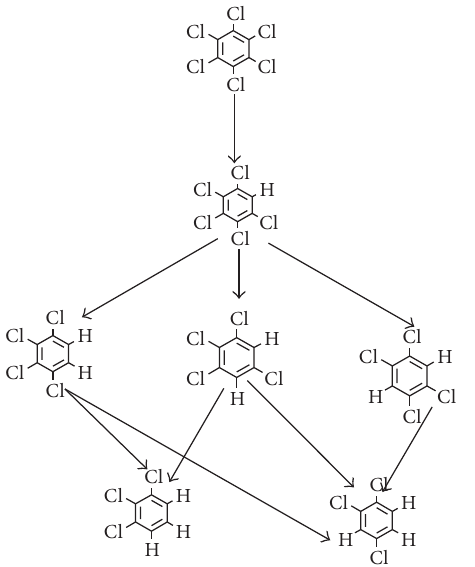
Figure 6: The proposed degradation pathway of HCB on stainless steel